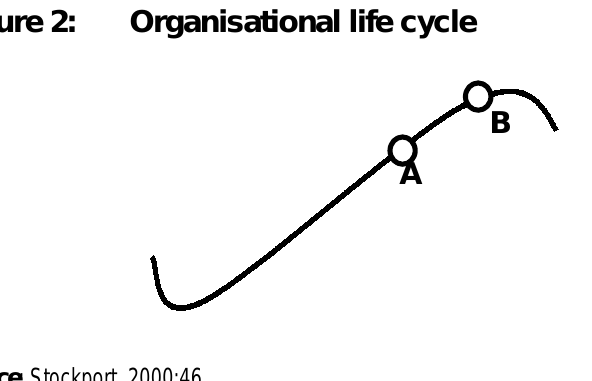
Organisational life cycle